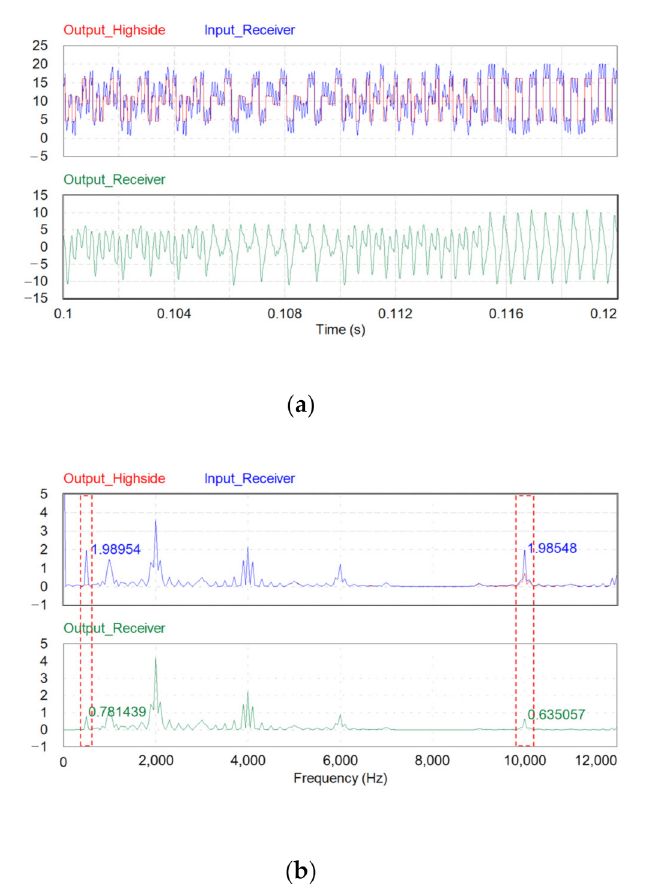
Figure 19. Response characteristics to disturbances of the receiver: ( a ) frequency response character- istics to disturbance; ( b ) FFT characteristics for disturbance.